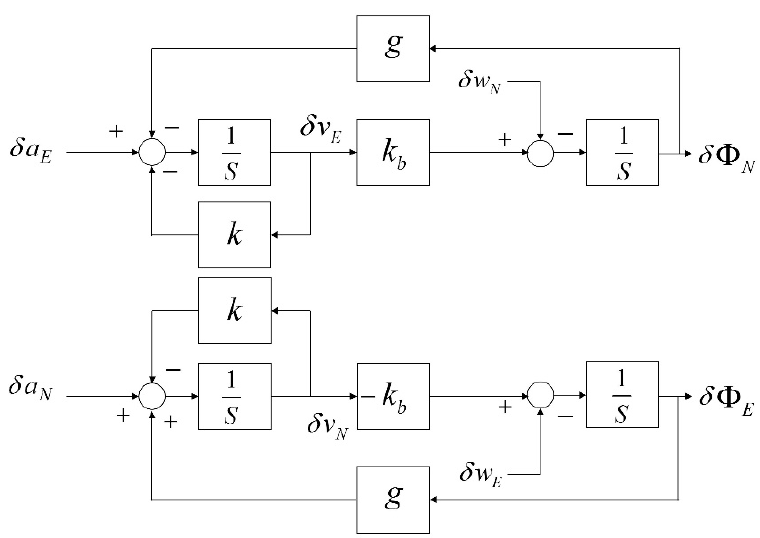
horizontal velocities ( (cid:1874) (cid:3006) , (cid:1874) (cid:3015) ) to make these velocities zero. A horizontal attitude (roll or pitch) is calculated by either control rate. Vertical attitude (heading) is calculated by both control rates.